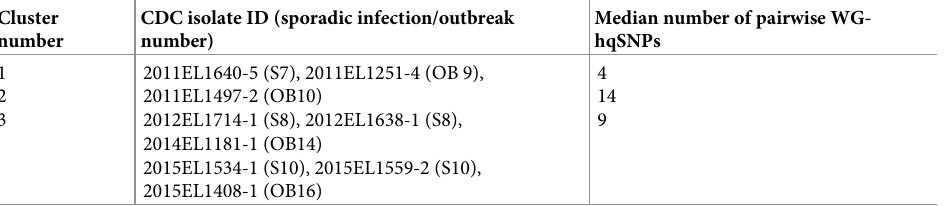
OB stands for outbreak; S stands for sporadic